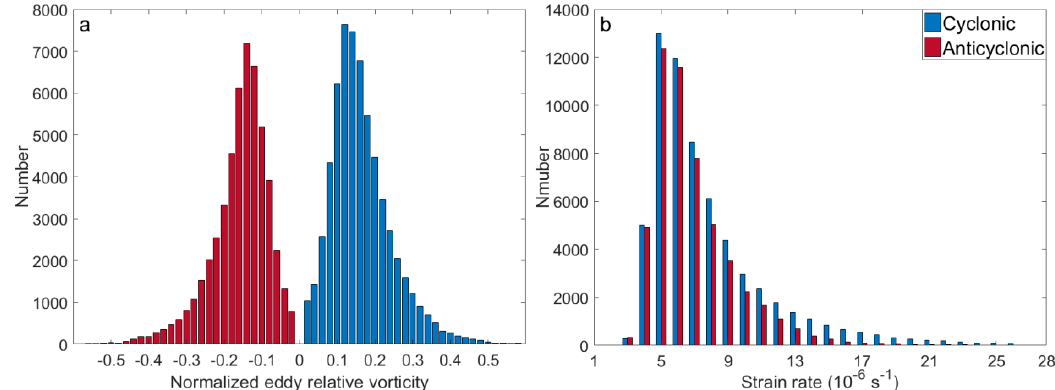
Figure 9. Histograms of ( a ) normalized eddy relative vorticity (divided by the local Coriolis parameter) and ( b ) strain rate (unit: s − 1 ).